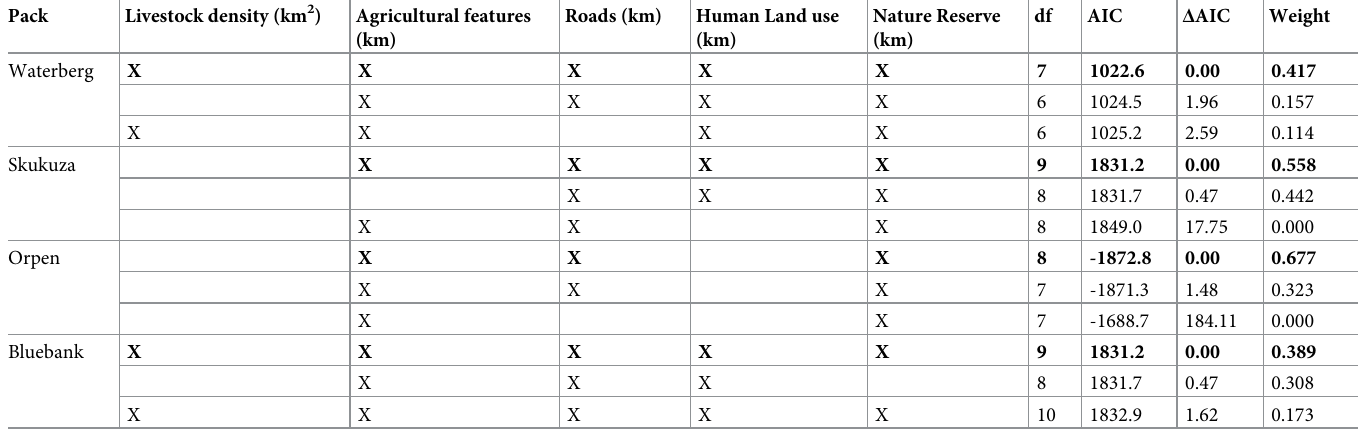
Table 2. Akaike Information Criterion (AIC) regression models investigating the effects of different features in a landscape on the space use of four African wild dog packs in the Limpopo and Mpumalanga provinces, South Africa. Columns marked with an ‘X’ indicate features included in the models. The most parsimonious models are indicated in bold for each pack and were used in all subsequent